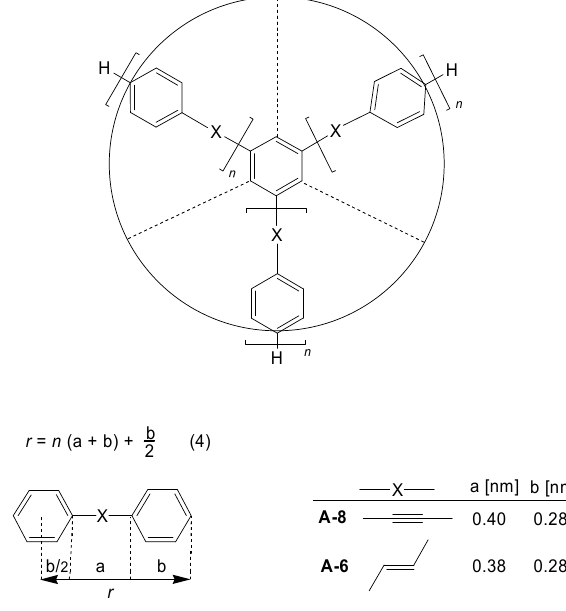
Figure 4. Disc-like shape of [3]star compounds with a benzene core C-4 and A-6 or A-8 arms in 1,3,5-position. The diameter of the discs amounts to d = 2 n  a + (2 n +1)b for the n th generation.